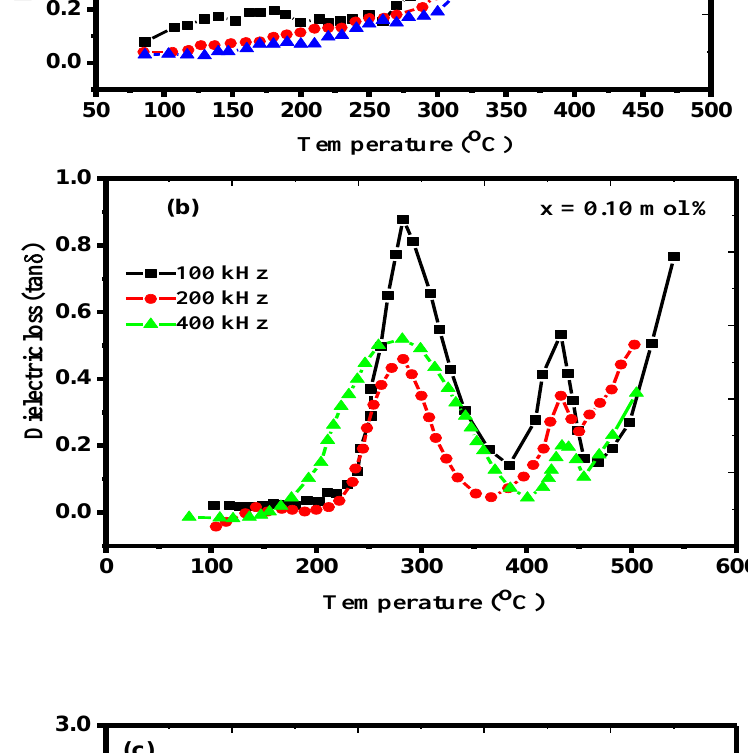
where τ λ (q) denotes relaxation time and Ω λ (q) denotes the phonon frequency [28]. Alt- hough the over-damped soft phonon mode temperature and dielectric relaxation behavior ended up being practically indistinguishable, the permittivity of the ceramics exhibits an abrupt change at the transition temperature (T C ) when the soft phonon mode damping and relaxation impact were insignificant. Moreover, term {1 + Ω λ2 (q) τ λ2 (q)} in the denom- inator of the above expression alters the sharp transition to a rounded hump. The maxi- mum loss and relaxation effect could be attributed to the condition Ω λ (q) = 1/ τ λ (q). The origin of phase transitions indicating dielectric irregularity originated from the unit cell structure, which is temperature-sensitive, and transformed into a progressively steady structure at a particular transition temperature. When the lattice is not able to relax against lattice stresses, assemblies of TiO 6 are intensely contorted, and Ti 4+ ions lie at its center of mass in an intact oxygen octahedron, developing permanent dipoles. Generally, these di- poles rearrange themselves toward the applied field, resulting in a substantial polariza- tion influence and, consequently, spontaneous polarization in all compositions. It can be understood from Figure 5 that the variation of tangent loss with temperature shows an extremely large energy loss near transition (but below T c ). Intense molecular thermal vi- brations above T c destroy spontaneous polarization, bringing decay in permittivity. Thus,